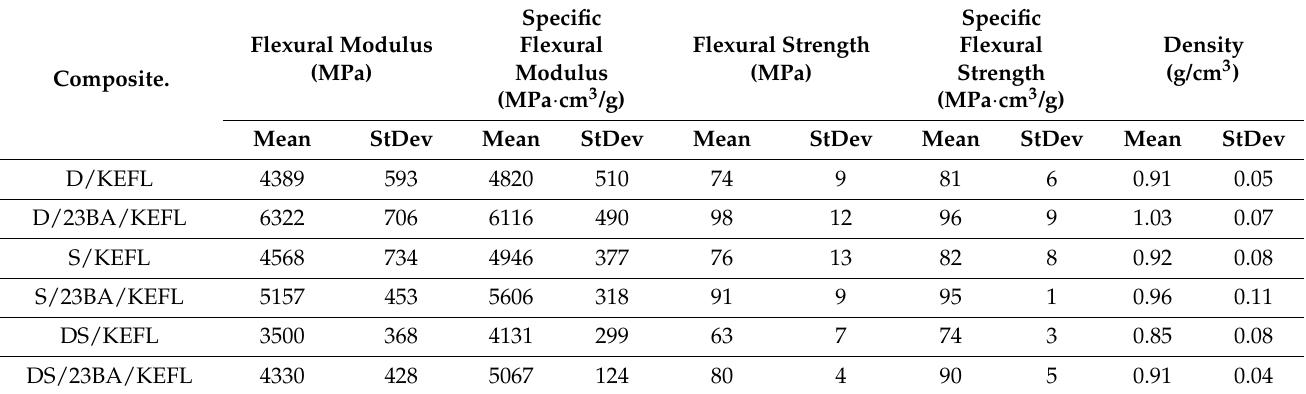
Table 5. Flexural mechanical properties of